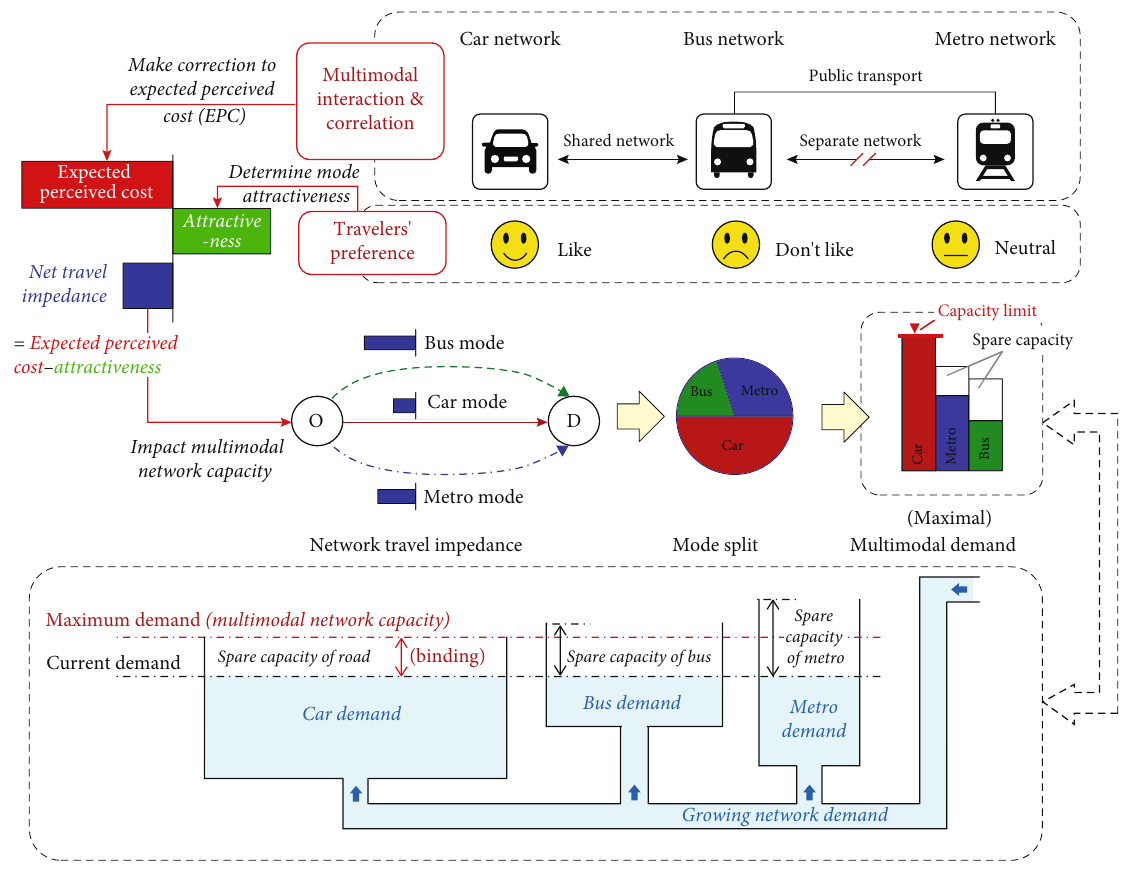
Figure 1: Concept of the network capacity analysis for multimodal transportation system.